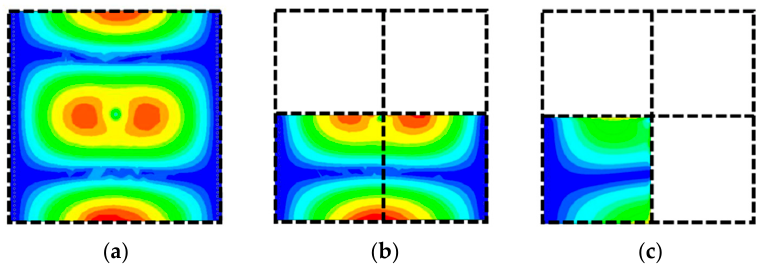
Figure 4. E-field amplitude plots of ( a ) a full-section of SIW, ( b ) a half-section cut in the transverse symmetric axis, and ( c ) a quarter-section cut in the longitudinal symmetric axis. Based on the QMSIW structure, the proposed antenna was designed, and its geome- try is shown in Figure 5. Two copper plates (patch and ground) were separated by air. The size of the patch corresponded to the size of QMSIW at 88 MHz determined by Equa- tion (1). There were three different kinds of cylindrical metallic posts in between the patch and ground: feeding probe, shorting pins, and via fence. The feeding probe was the inner conductor of a coaxial cable brought to the radio frequency (RF) source, while the shorting pins were directly connecting the patch and ground. The outer and inner conductors of the coaxial probe were electrically connected to the lower ground and upper patch, re- spectively. The diameter of the shorting pins was 1 mm, which corresponded to a gauge size of 18. Their locations were carefully chosen relative to the feeding probe location to induce in-phase currents, thus promoting an omnidirectional radiation pattern [17]. By adding the shorting pins, the antenna resonant frequency was shifted lower, thus the an- tenna size parameters ( W , L ) were adjusted to shift it back. The QMSIW structure was formed by the via fence and two magnetic walls as depicted in Figure 5b. The via’s spacing and diameter were determined by Equation (2). Table 1 lists the geometrical parameters and their values, which were finalized after optimizing the initial model using the full- wave EM simulation tool, Ansys HFSS. Several key parameters such as the ground and patch size, feeding probe and shorting pin locations, numbers of vias and its diameter were optimized one by one to reach the dimensional values in Table 1. ( a )